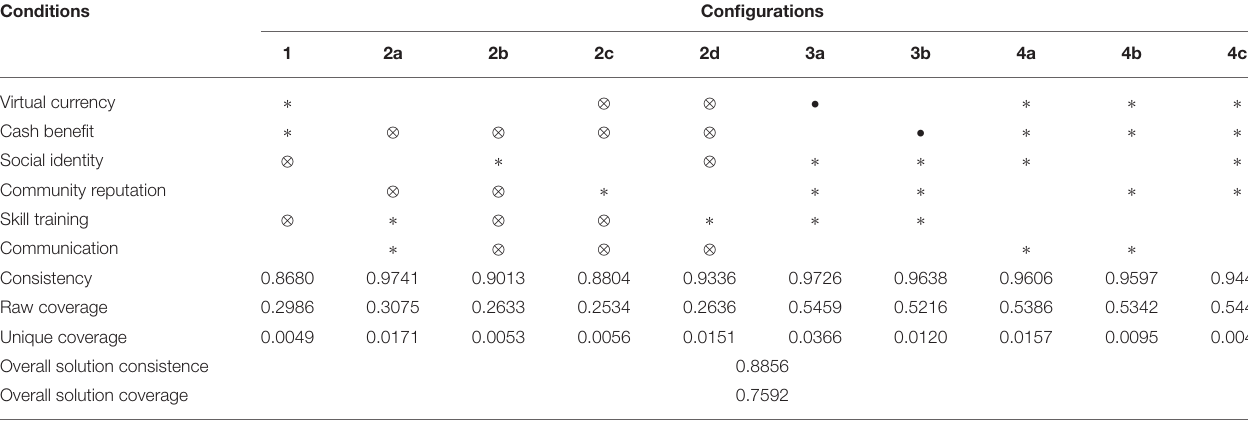
TABLE 4 | The configurations leading to high